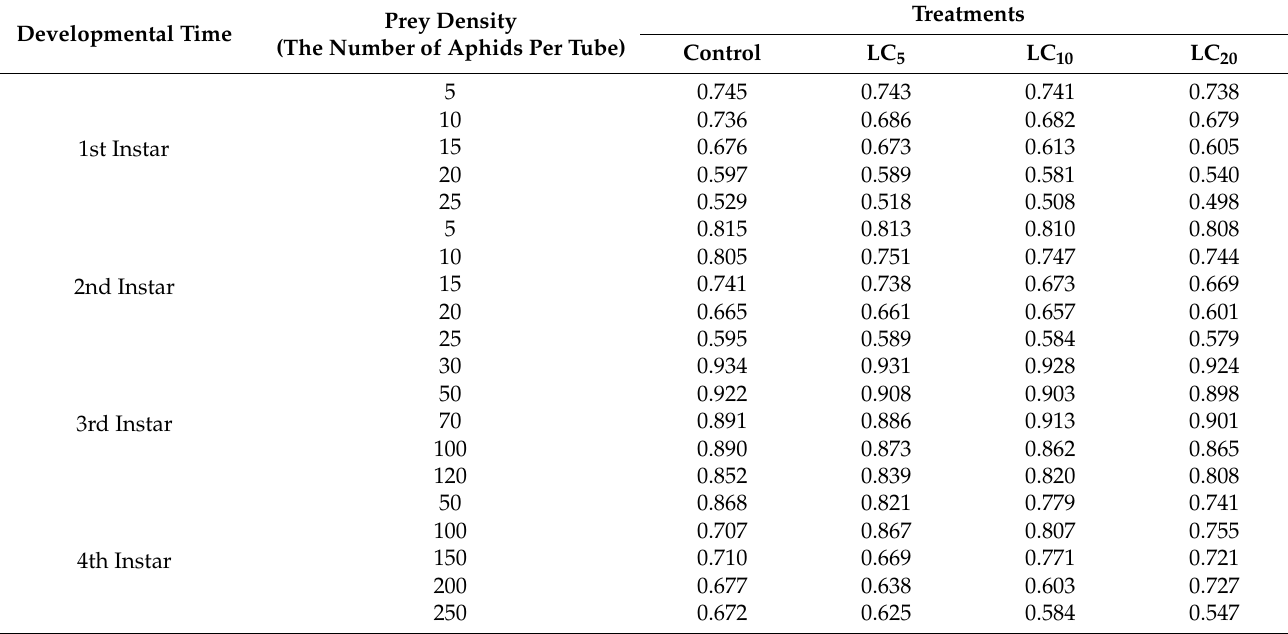
Table 4. Searching efficiency of C. septempunctata after exposing to acetamiprid in different larval